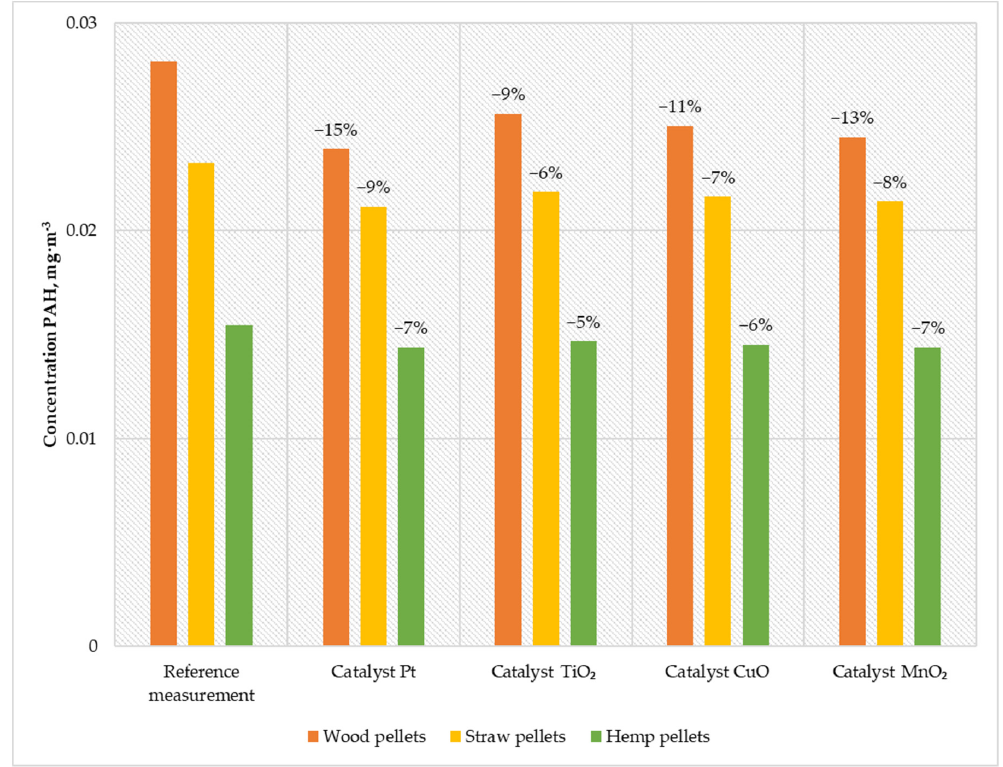
Figure 8. Average PAHs content in the flue gas from a low-power biomass boiler. The results obtained during the boiler operation with the developed catalysts proved that the most effective solution for reducing PAHs is using a platinum catalyst. The emis- sion of PAH during its use and feeding the boiler with wood pellets was 0.023 mg·m − 3 . Feeding the boiler with straw pellets, the emission remained at the level of 0.021 mg·m-3, while during the combustion of hemp pellets, the emission was 0.014 mg·m − 3 . The second most efficient solution is the manganese catalyst. When burning wood pellets, the emis- sion was reduced to 0.024 mg·m − 3 , burning straw pellets to 0.021 mg·m − 3 , and burning hemp pellets to 0.014 mg·m − 3 . The solution based on copper oxide was characterized by efficiency at the level of 11% when burning wood pellets, 7% when burning straw pellets, and 6% when burning hemp pellets. After installing the titanium catalyst, the PAH emis- sions generated during the combustion of wood pellets decreased by 9% while burning straw pellets by 6% and burning hemp pellets by 5%.